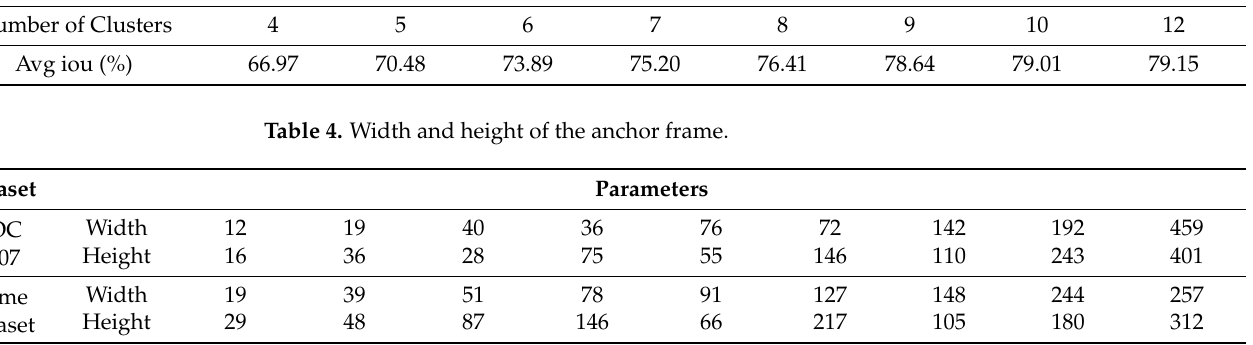
Table 5. Basic configuration of the local computer.